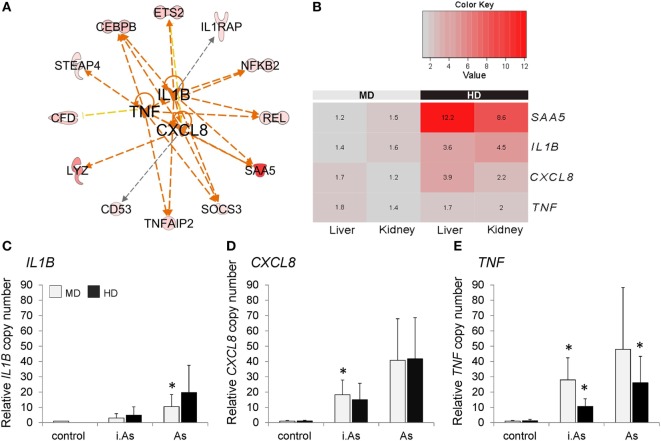
(A) IPA upstream regulator analysis predicted IL1B, CXCL8, and TNF to control the overexpression of 12 genes in both liver and kidney in high density (HD) conditions compared with those in moderate density (MD) conditions. Orange lines indicate an activating impact on gene expression, while yellow and black lines indicate inconsistent or non-predicted effects. The network was manually edited; please note that ingenuity analysis is based on literature about mammalian molecules. (B) The heat map displays expression ratios [given as fold change (FC)] of SAA5, IL1B, CXCL8, and TNF (normalized to RPL9) in the liver and head kidney of maraena whitefish (n = 8). The bar above the heat map indicates the density categories analyzed. Scaled color intensity within each row verifies high FC > 2.0 (shades of red). Significance levels were determined using analysis of variance (ANOVA) analysis and Bonferroni posttest. The transcription levels of (C)
IL1B, (D)
CXCL8, and (E)
TNF were evaluated in head kidney leukocytes 12 h after cocultivation with inactivated (i.As) and viable A. salmonicida (As). Leukocytes had been isolated from fish kept at MD (light gray bars) or HD (black). Graphs depict the mean values + SD (error bars). Significant changes (p ≤ 0.05) compared with controls are marked with “*” as evaluated using one-way ANOVA.